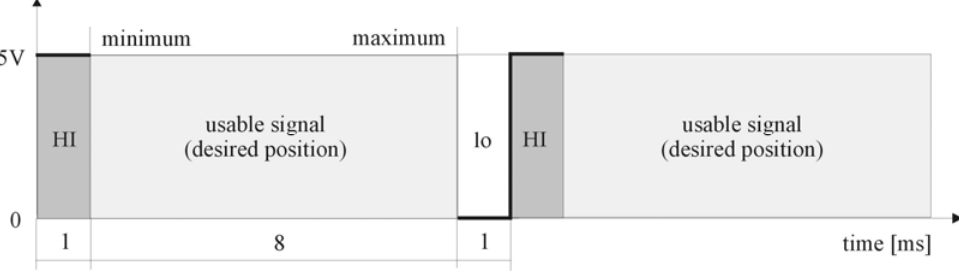
Fig 5. PWM standard established for EMA inputs